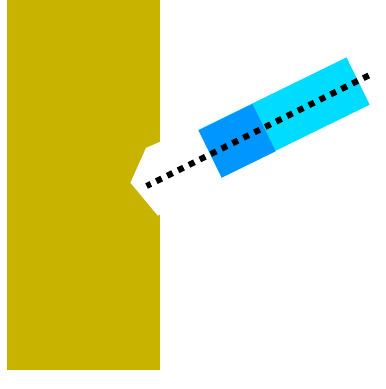
Figure A1. Modfying the segment. Remove the appendage (red) resulting from the base of the branch (blue) from the segment. The black dotted line shows the axis of the